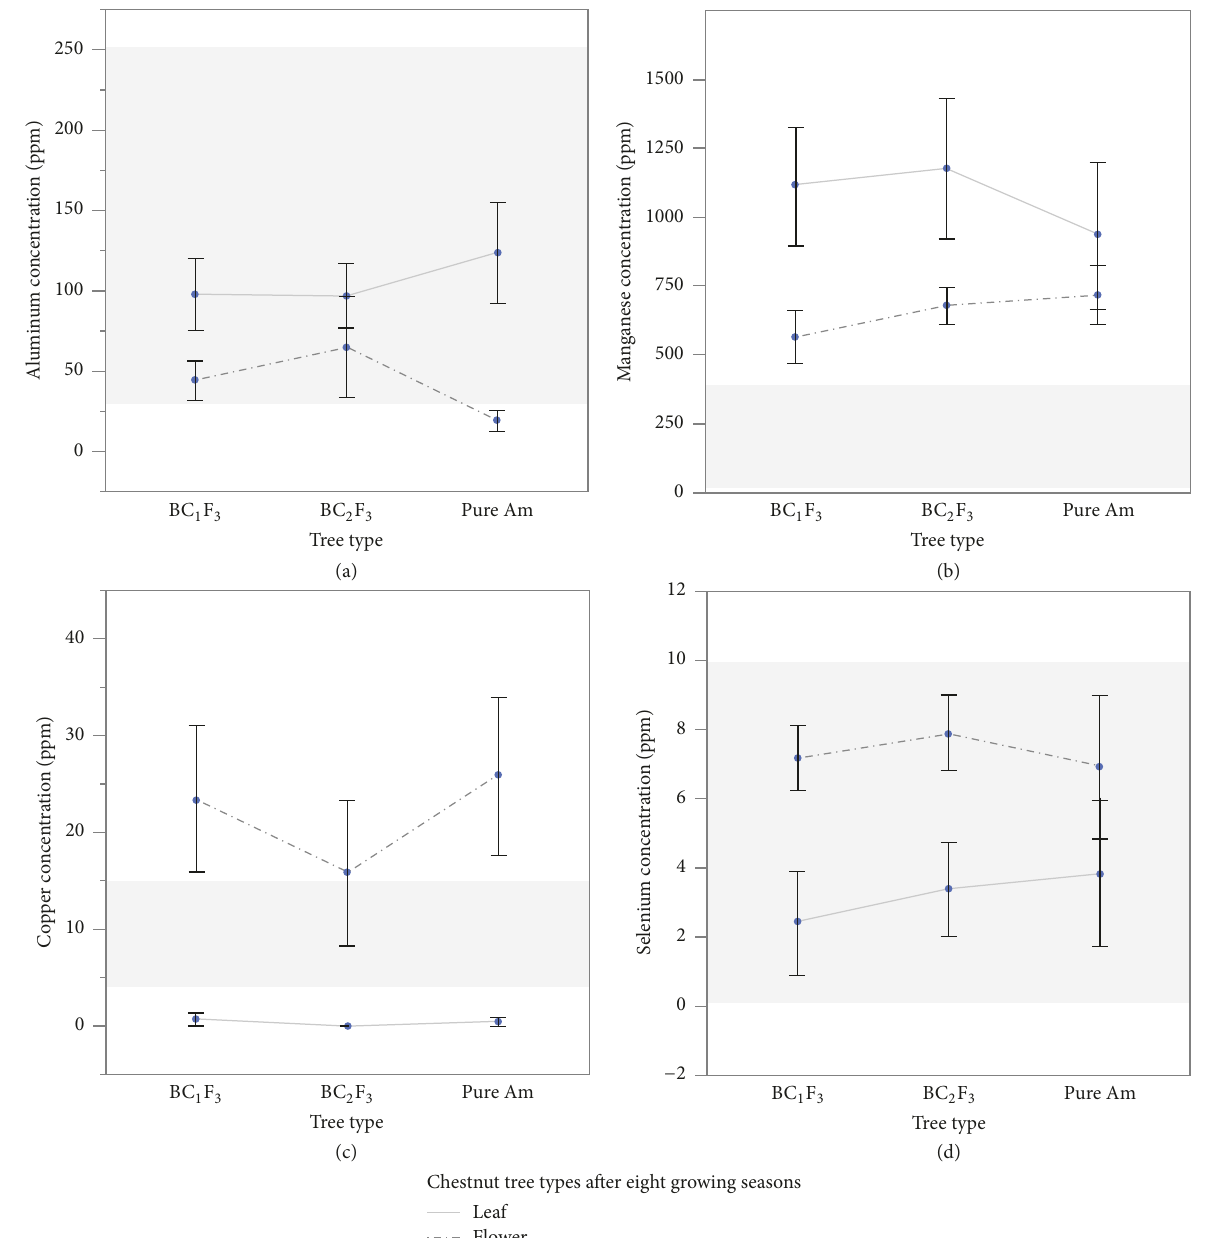
Figure3:Meanleaftissue(graylines)andfloraltissue(brokendarkgray)metalconcentrations( 𝑛 = 22